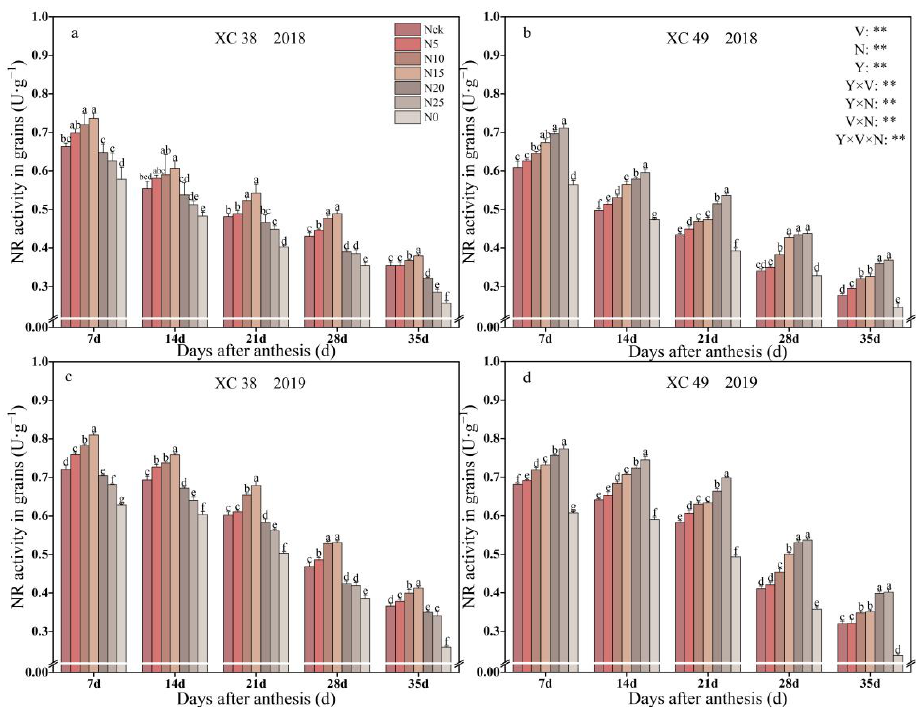
Figure 2. Effects of different nitrogen treatments on NR activity in grain in 2018 and 2019. ( a ) NR activity of XC 38 grains in 2018; ( b ) NR activity of XC 49 grains in 2018; ( c ) NR activity of XC 38 grains in 2019; ( d ) NR activity of XC 49 grains in 2019. XC 38: Xinchun 38; XC 49: Xinchun 49; Nck: 300 kg hm − 2 , N5: 285 kg hm − 2 , N10: 270 kg hm − 2 , N15: 255 kg hm − 2 , N20: 240 kg hm − 2 , N25: 225 kg hm − 2 , N0: 0 kg hm − 2 ; V: Variety, N: Nitrogen, Y: Year. ** represents significant differences at 0.01 level. Different lowercase letters in the figure represent significant differences at the 0.05 level. Table 2. ANOVA of wheat grain physiological indicators under variety and nitrogen fertilizer interaction.